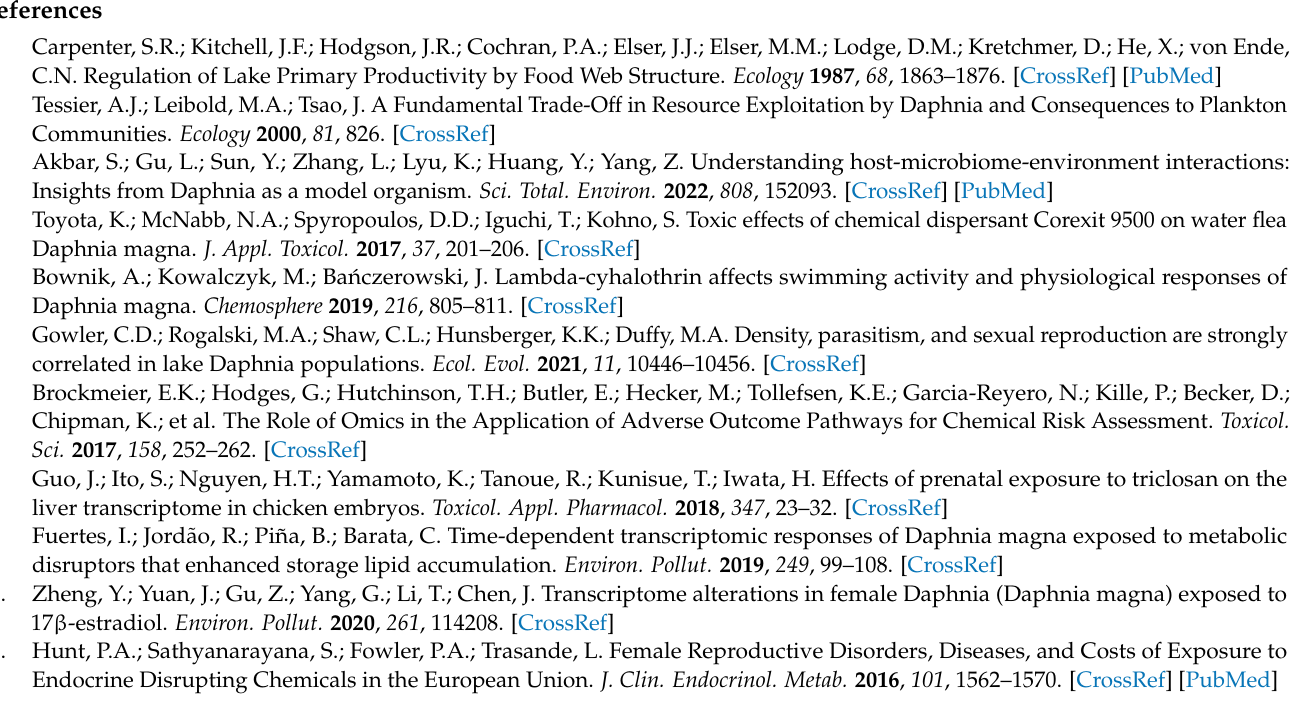
expression profiles of D. magna after 9 d exposure to DES at 200 µ g L − 1 volcano plot compared with solvent control groups; Figure S5: Gene expression profiles of D. magna after 9 d exposure to DES at 1000 µ g L − 1 volcano plot compared with solvent control groups; Figure S6: qRT-PCR and RNA-seq correlation analysis results diagram of selected genes. NPC2: Niemann-Pick C2 protein; abat: 4- aminobutyrate aminotransferase; Figure S7: After a 9-d of exposure to different concentrations of DES, the top 20 enrichment terms for each category were significantly higher in the 2 µ g L − 1 treatment group than in the solvent control; Figure S8: After a 9-d of exposure to different concentrations of DES, the top 20 enrichment terms for each category were significantly higher in the 200 µ g L − 1 treatment group than in the solvent control; Figure S9: After a 9-d of exposure to different concentrations of DES, the top 20 enrichment terms for each category were significantly higher in the 200 µ g L − 1 treatment group than in the solvent control; Table S1: Primers utilised for quantitative polymerase chain reaction (qPCR) validation of gene expression; Table S2: List of fundamental pathways affected by a 9-day exposure to